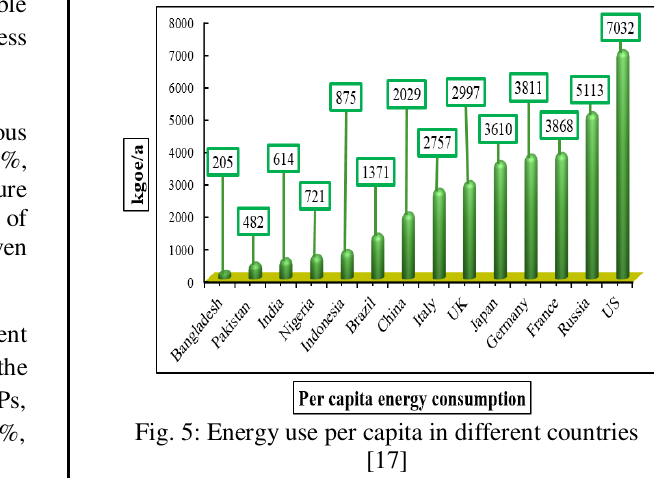
Fig. 5: Energy use per capita in different